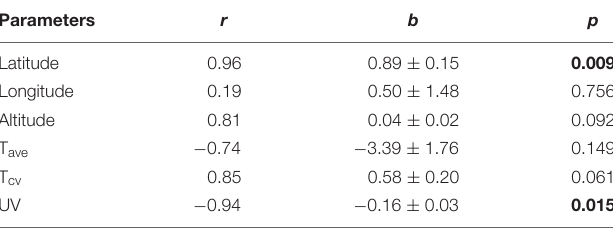
TABLE 2 | Regression analysis of pigmentation with various geographical and climatic